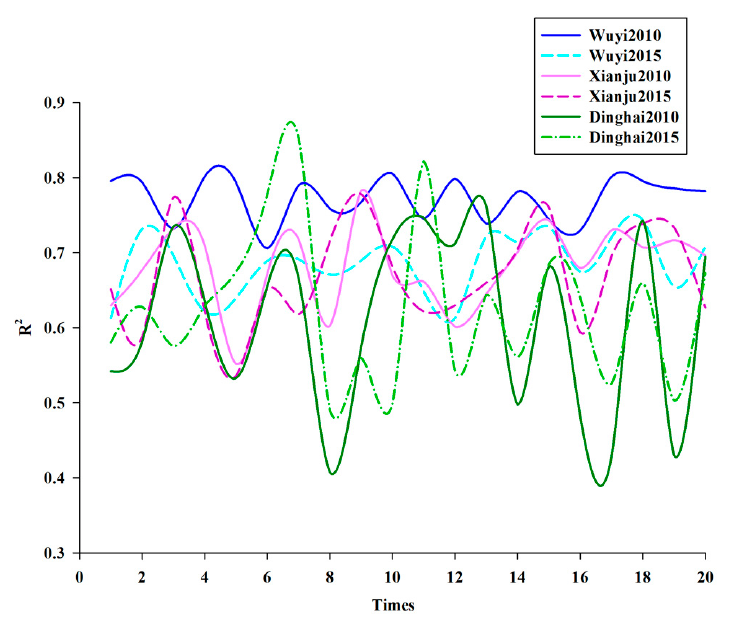
Figure 4. Prediction accuracy ( R 2 ) of modeling in different regions.